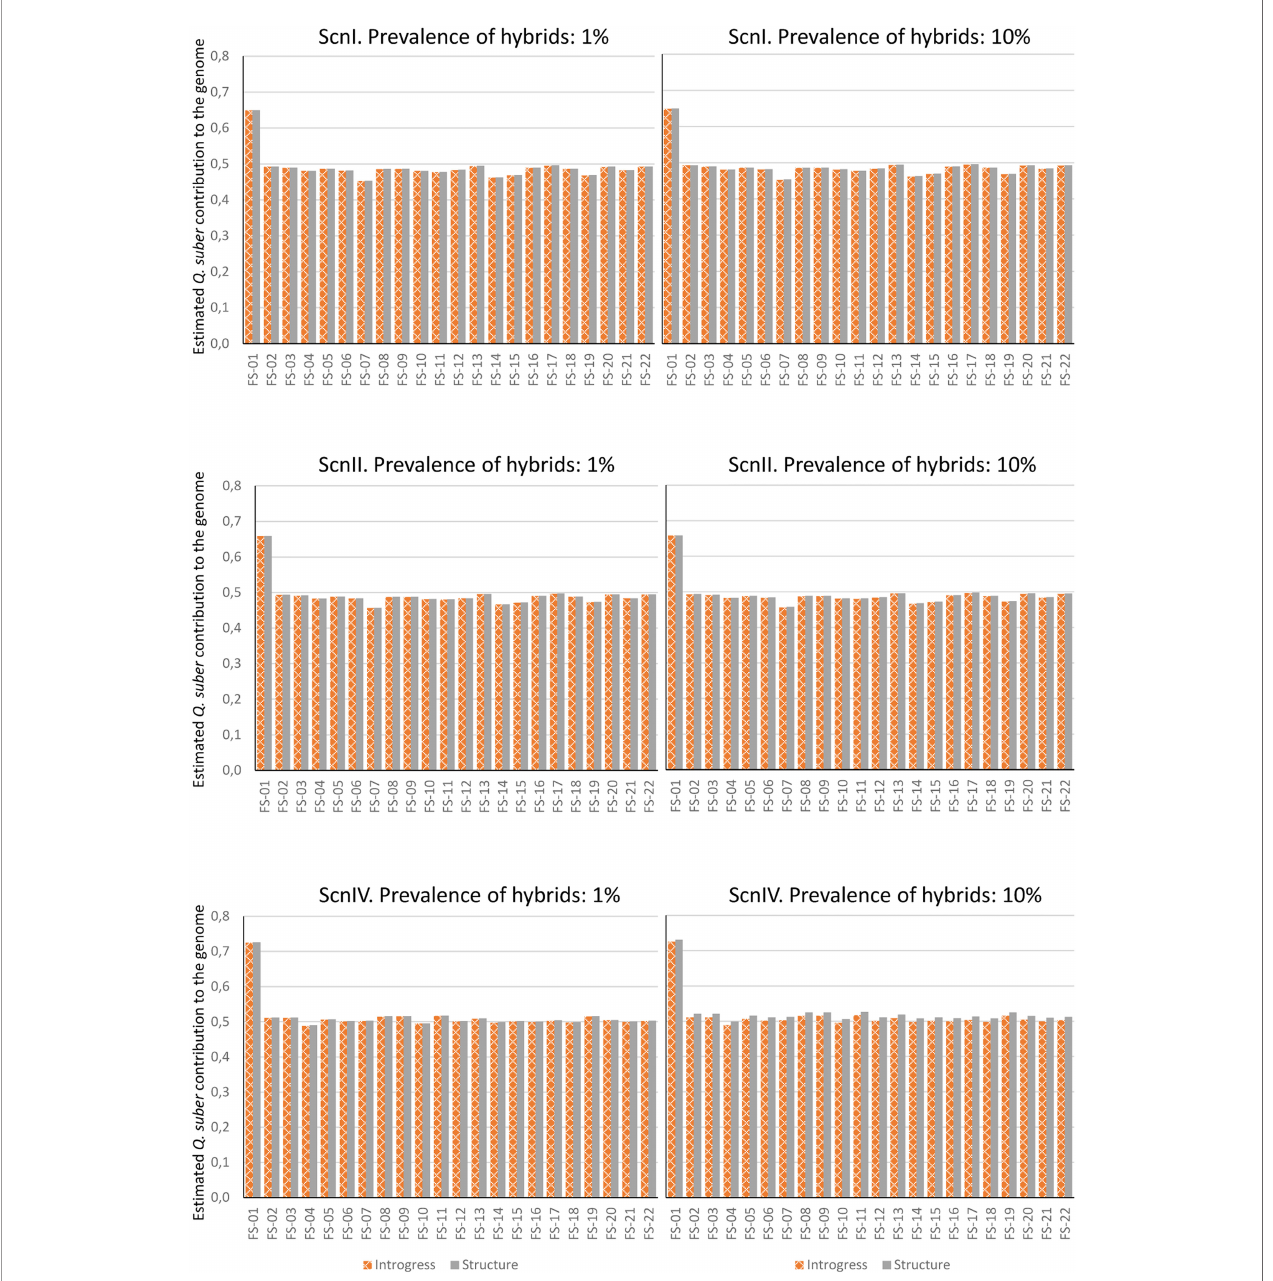
FIGURE 7 | Contribution of Q. suber to the genome of adult hybrids under each scenario, estimated by means of STRUCTURE's qs and Hybrid Index of INTROGRESS, with 1% and 10% of